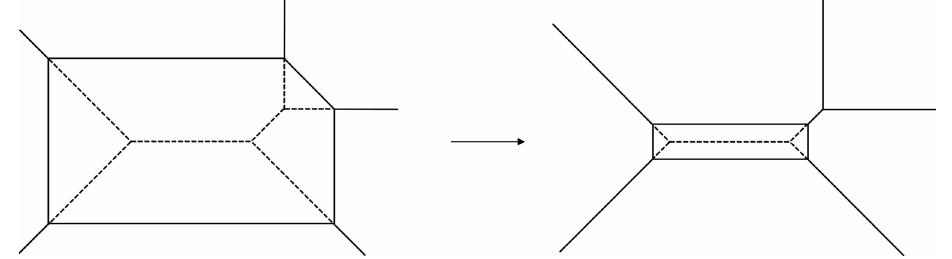
Figure 23 . The flop transition of dP 2 theory in terms of brane web.